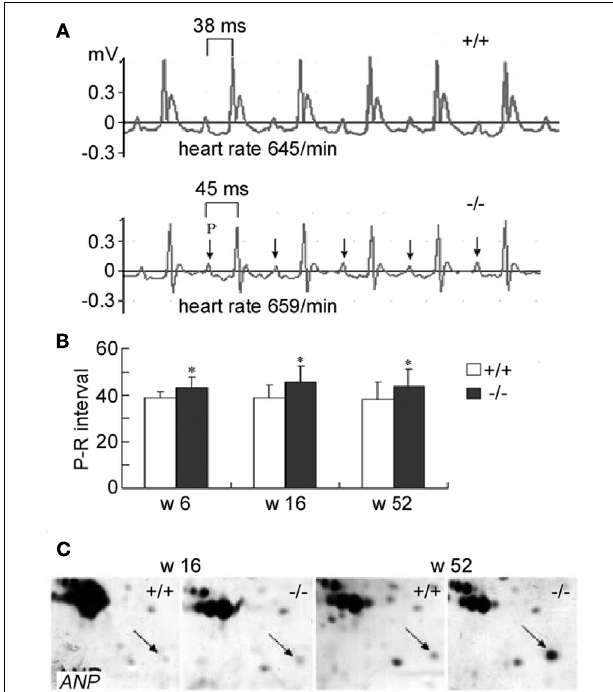
FIGURE 6 | Surface electrocardiogram and action potential in mice lacking UT-B. (A) The II standard lead ECG ofWT and UT-B null mice. (B) The P-R interval inWT and UT-B null mice (mean + SD, n = 20, * p < 0.05 vs. WT mice). (C) The expression level of ANP in 16- and 52-week-oldWT and UT-B null mice. Reproduced from Meng et al. (2009),Yu et al.